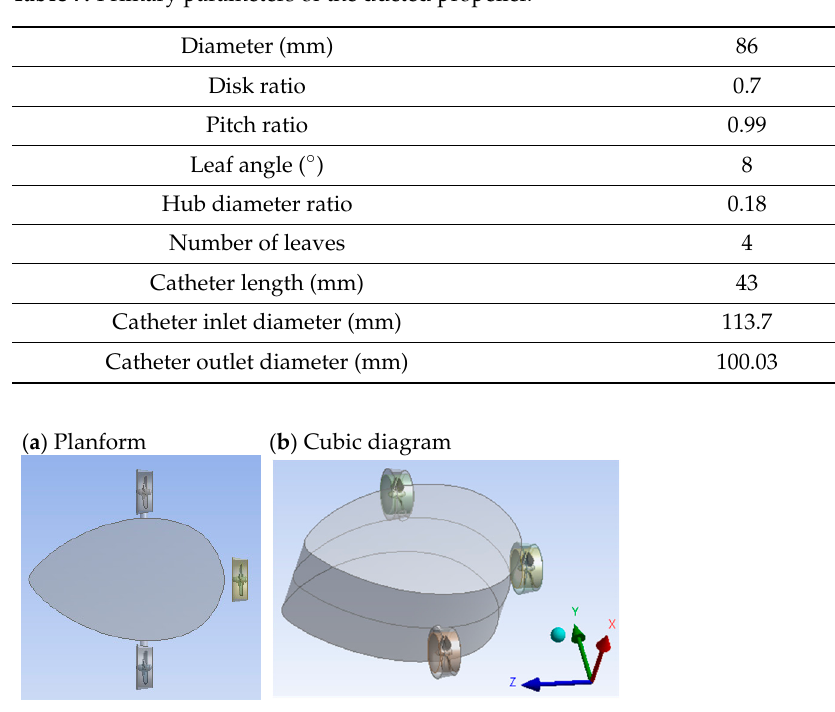
Figure 10. Geometrical model of the underwater robot. ( a ) Planform; ( b ) Cubic diagram